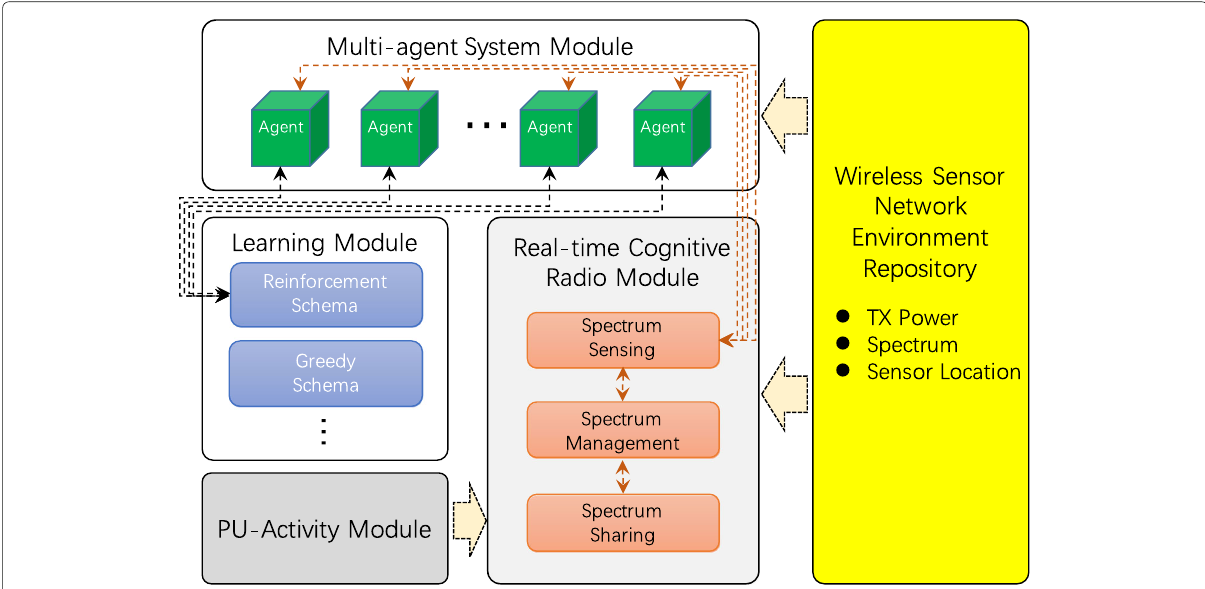
Fig. 5 Block diagram of the implemented simulator tool for RL-based cognitive